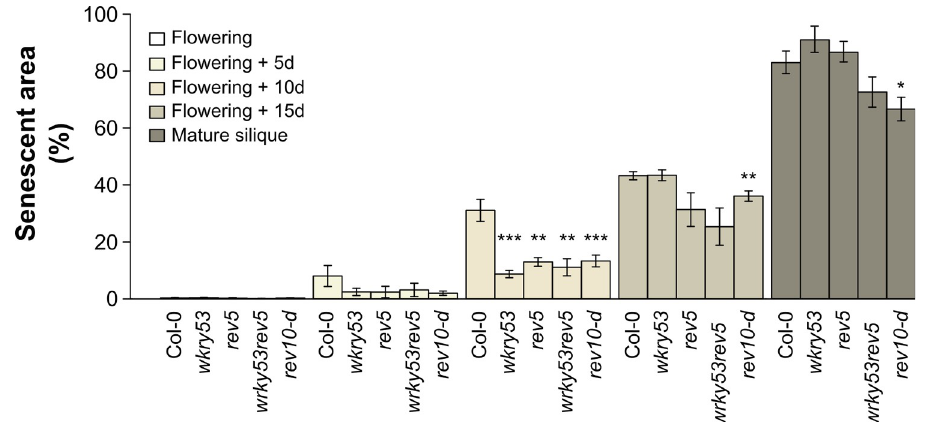
Fig 1. Analysis of senescence progression in the different REV and WRKY53 mutants. Percentage of senescent area throughout the development from flowering to mature silique using chlorophyll fluorescence imaging. Senescent area was calculated by the ratio between pixel number for a photosynthetic efficiency F v / F m � 0.6 and the total pixel number of the rosette. Flowering was reached when the first flower was open. Mature silique stage was considered from the first yellowing siliques. Data are means ( ± SE) of 5–30 plants per genotype. Significant differences were analysed using Kruskal–Wallis tests: � : P � 0.05, �� : P � 0.001, and ��� : P � 0.0001. See also S1 Fig.